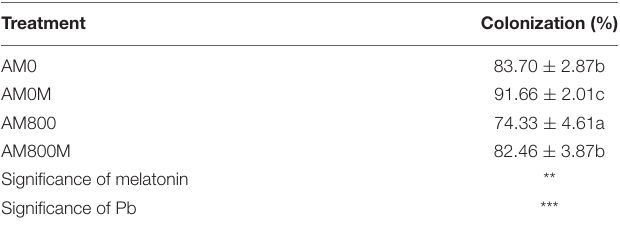
TABLE 1 | The AM colonization of M. truncatula under Pb stress and melatonin application.